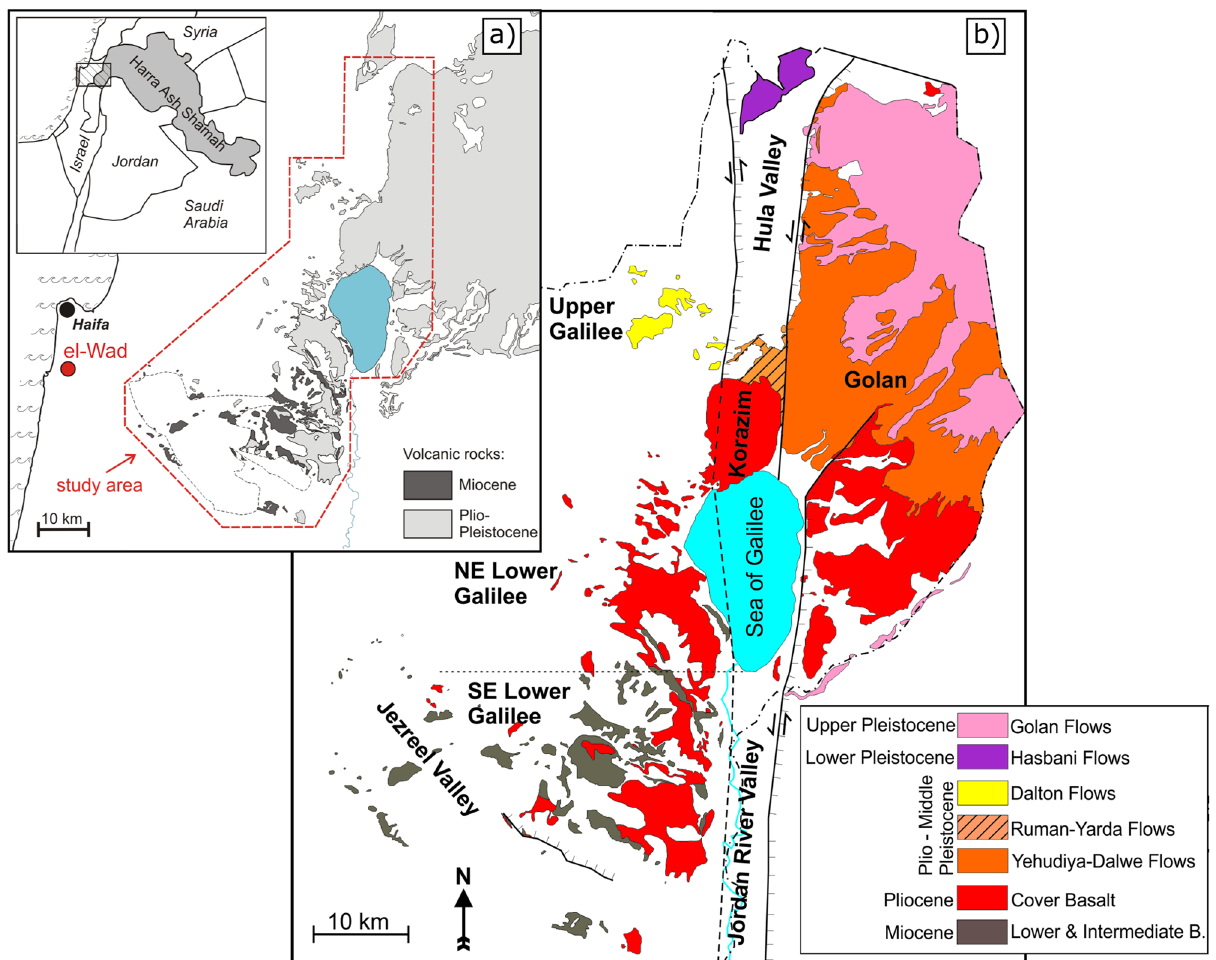
Sneh and Weinberger 38,39 and Sneh et al. 40 (created by T.G. in QGIS Pisa and Inkscape